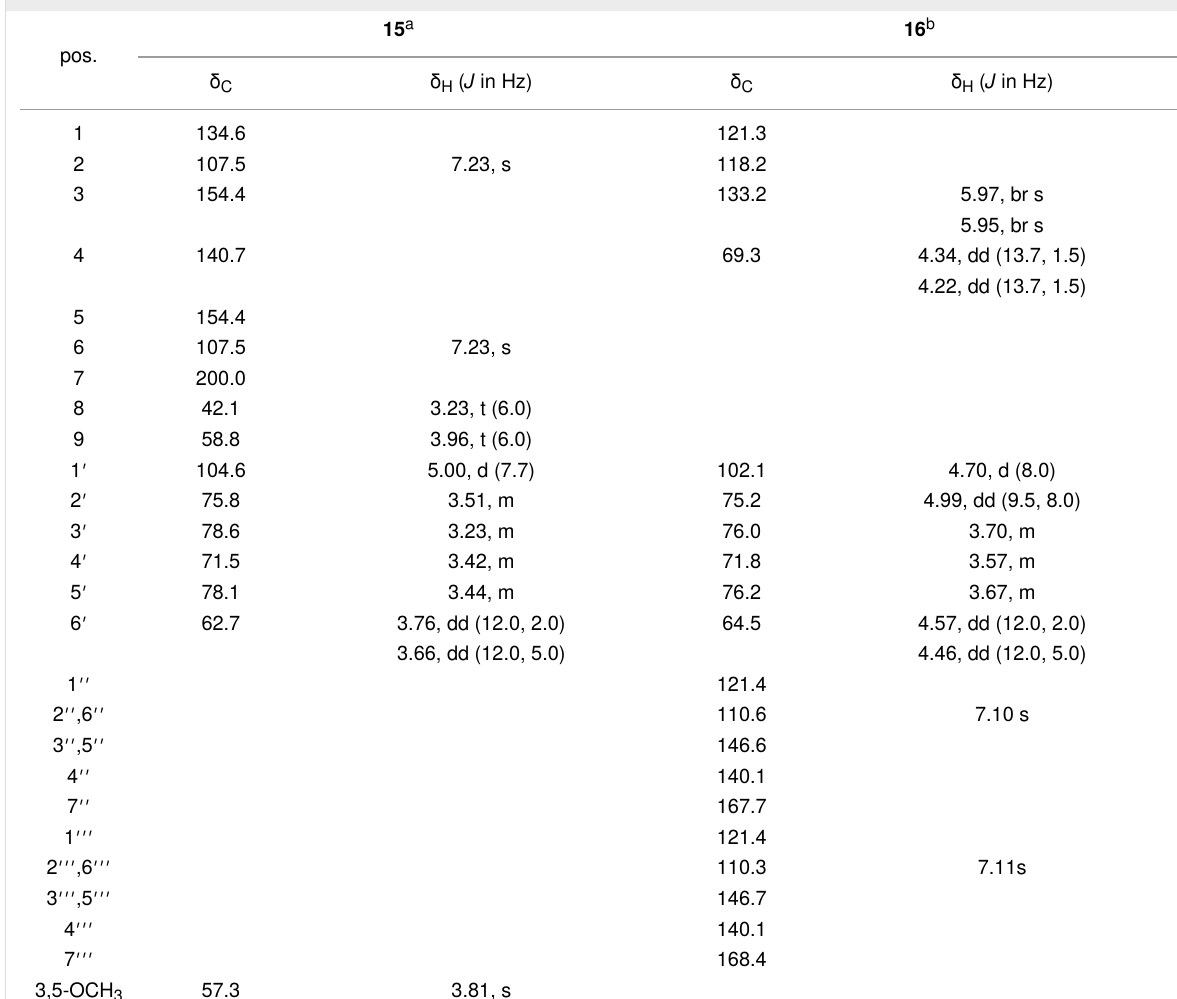
Table 2: 1 H and 13 C NMR spectral data of 15 and 16 in CD 3 OD.